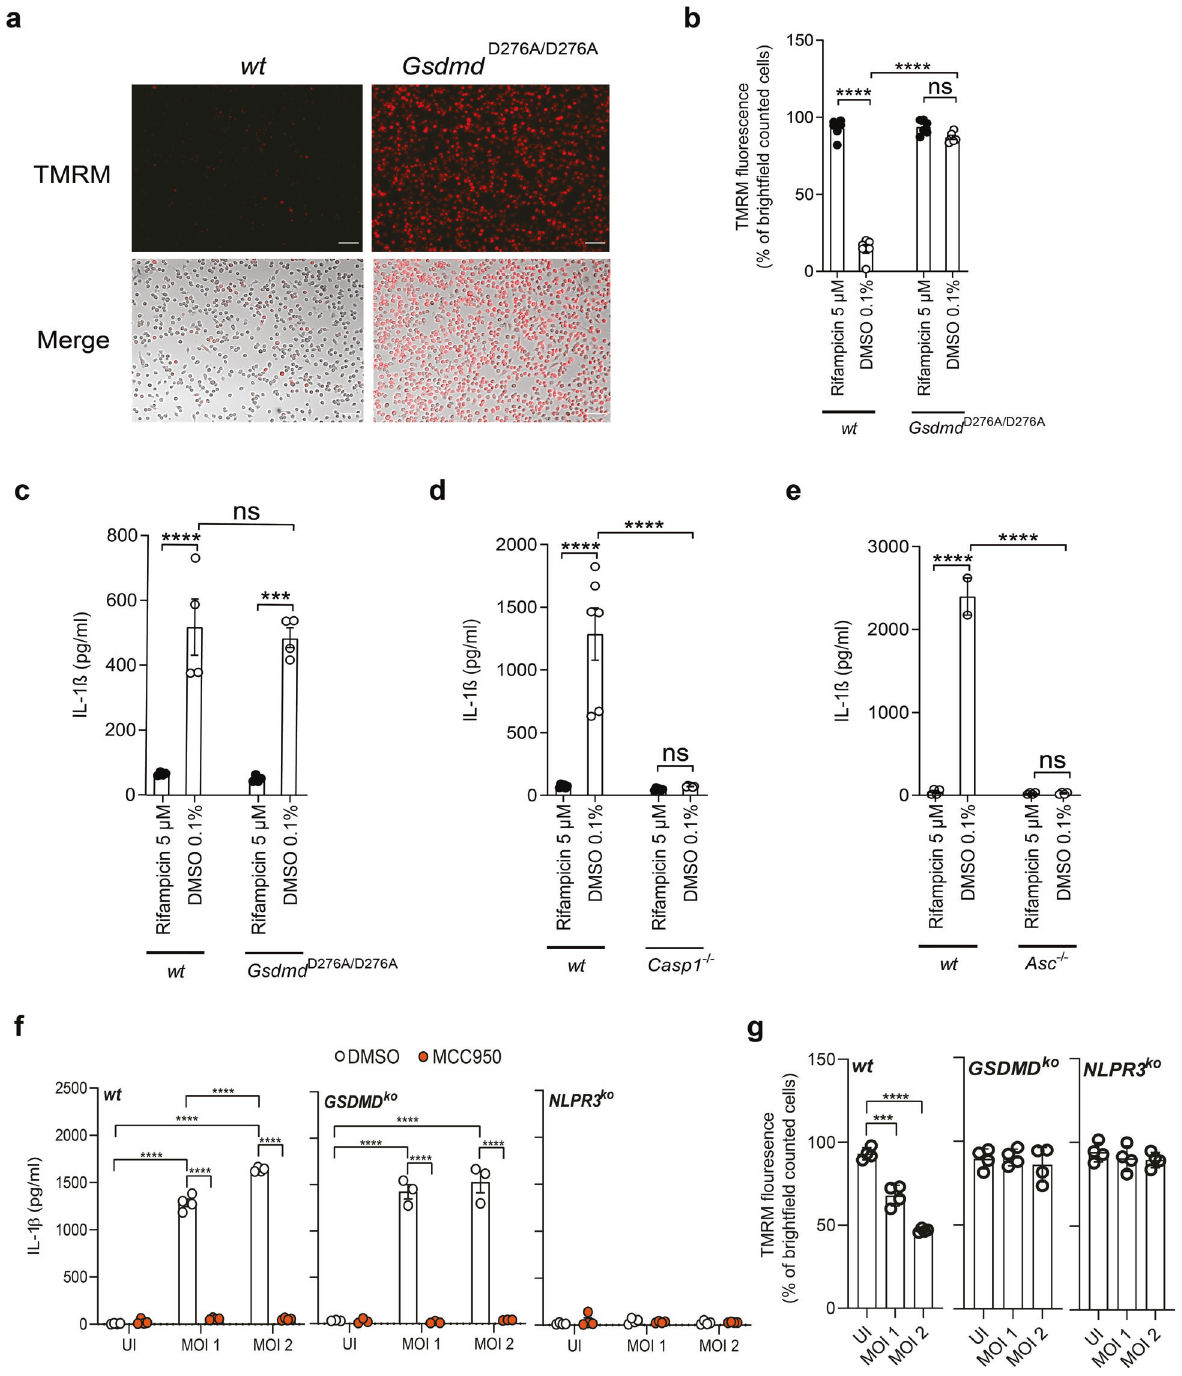
Fig. 5 GSDMD is important for mitochondrial integrity but not IL-1 β secretion. a Representative images and b quanti fi cation of TMRM in Mtb -infected Gsdmd D276A BMDM 24 h post infection (scale bar: 100 μ m; n = 6). Data from at least two experiments with multiple replicates are shown. Results are expressed as mean ± SEM. Analysis was done using one-way ANOVA with Bonferroni post-test (ns, not signi fi cant; *** p ≤ 0.001; **** p ≤ 0.0001). Quanti fi cation of IL-1 β concentration (pg/ml) in the supernatant of c Gsdmd D276A ( n = 4), d casp1 − / − ( n = 6), and e Asc − / − ( n = 4) BMDMs 24 h post infection. f IL-1 β concentration (pg/ml) from THP-1 cells ( n = 4 for wt , GSDMD ko , and NLPR3 ko THP-1 cells), which were infected with Mtb for 24 h (MOI as indicated). Before infection, cells were treated for 2 h with DMSO (0.1%, white circle) or MCC950 (10 µM, orange circle). g TMRM quanti fi cation from THP-1 cells ( n = 4 for wt , n = 3 for GSDMD ko , and n = 4 for NLPR3 ko THP-1 cells), which were infected with Mtb for 24 h (MOI as indicated).